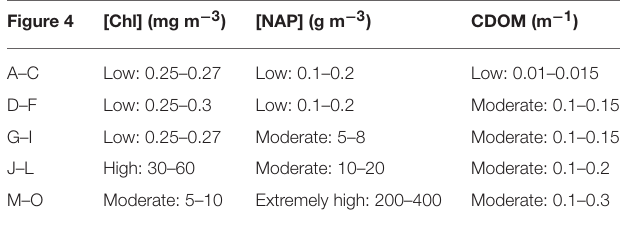
TABLE 2 | Corresponding variations of [Chl], [NAP] and CDOM for R rs ( λ ) spectra in Figure 4 . Figure